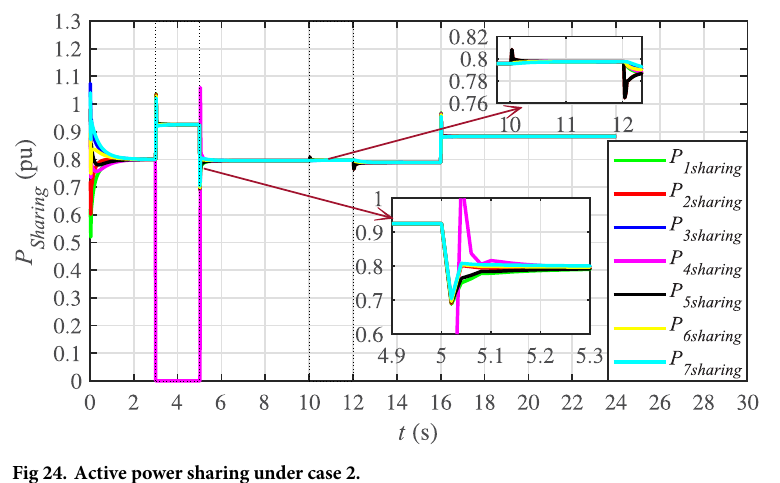
Fig 24. Active power sharing under case